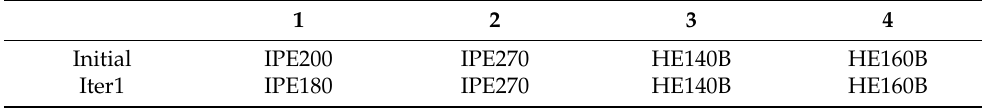
Figure 12. The layout of Frame A. Table 4. Frame A: Member sections in each